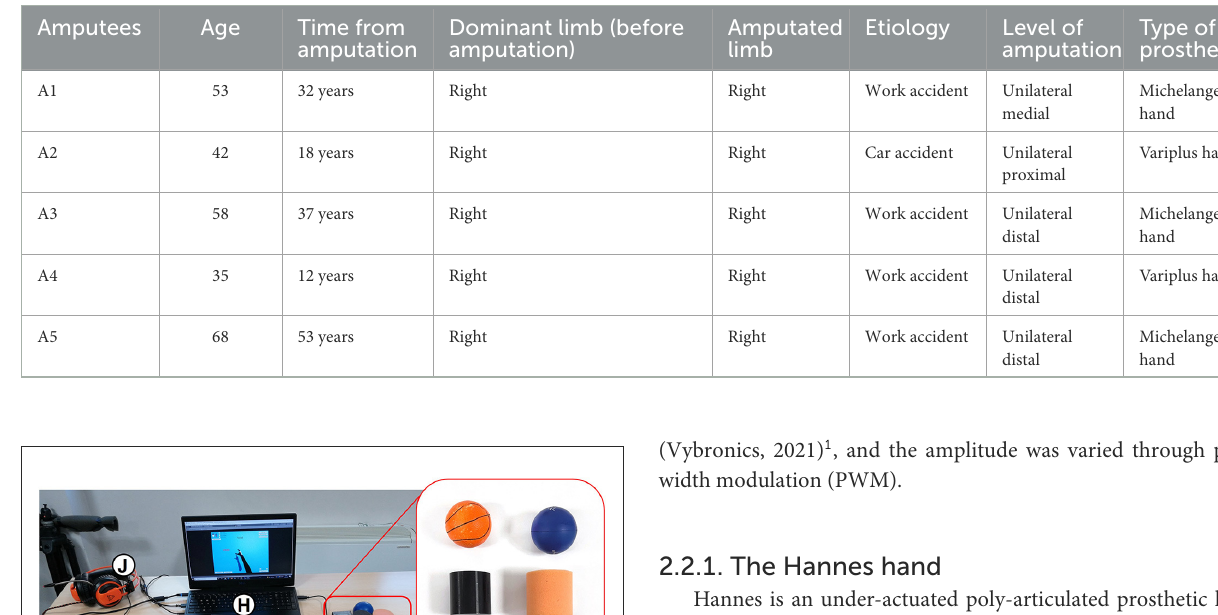
TABLE 1 Population of amputees.